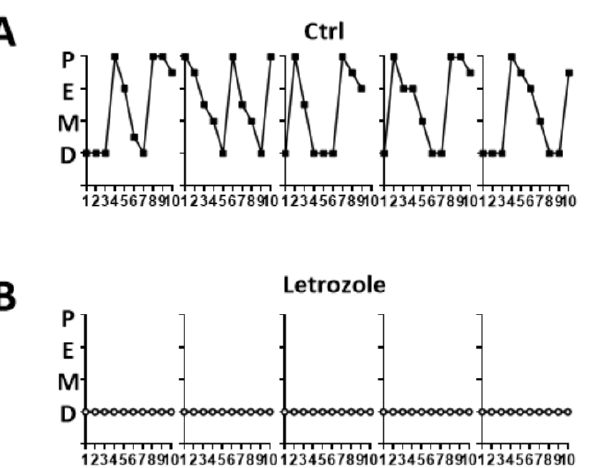
Figure 1. The estrous cycle pattern in the control group ( A ) and the letrozole-treated mice ( B ). The control mice showed a normal estrous cycle, whereas the estrous cycle of the letrozole-treated